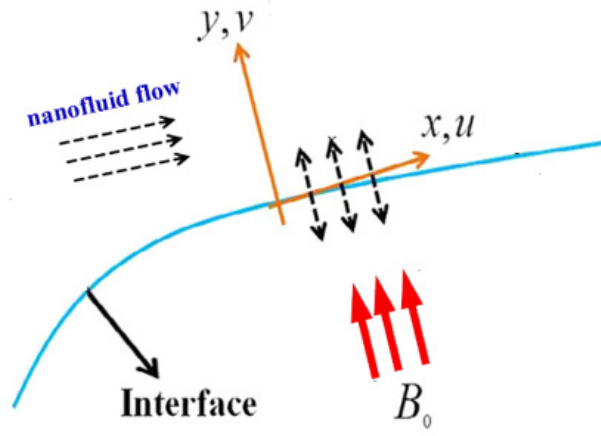
Figure 1. Flow Figure 1. Flow description.